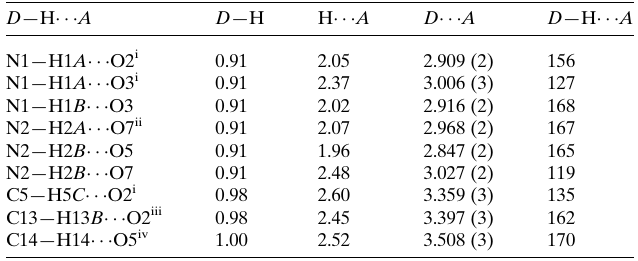
Table 1 Hydrogen-bond geometry (A˚ , (cid:4)